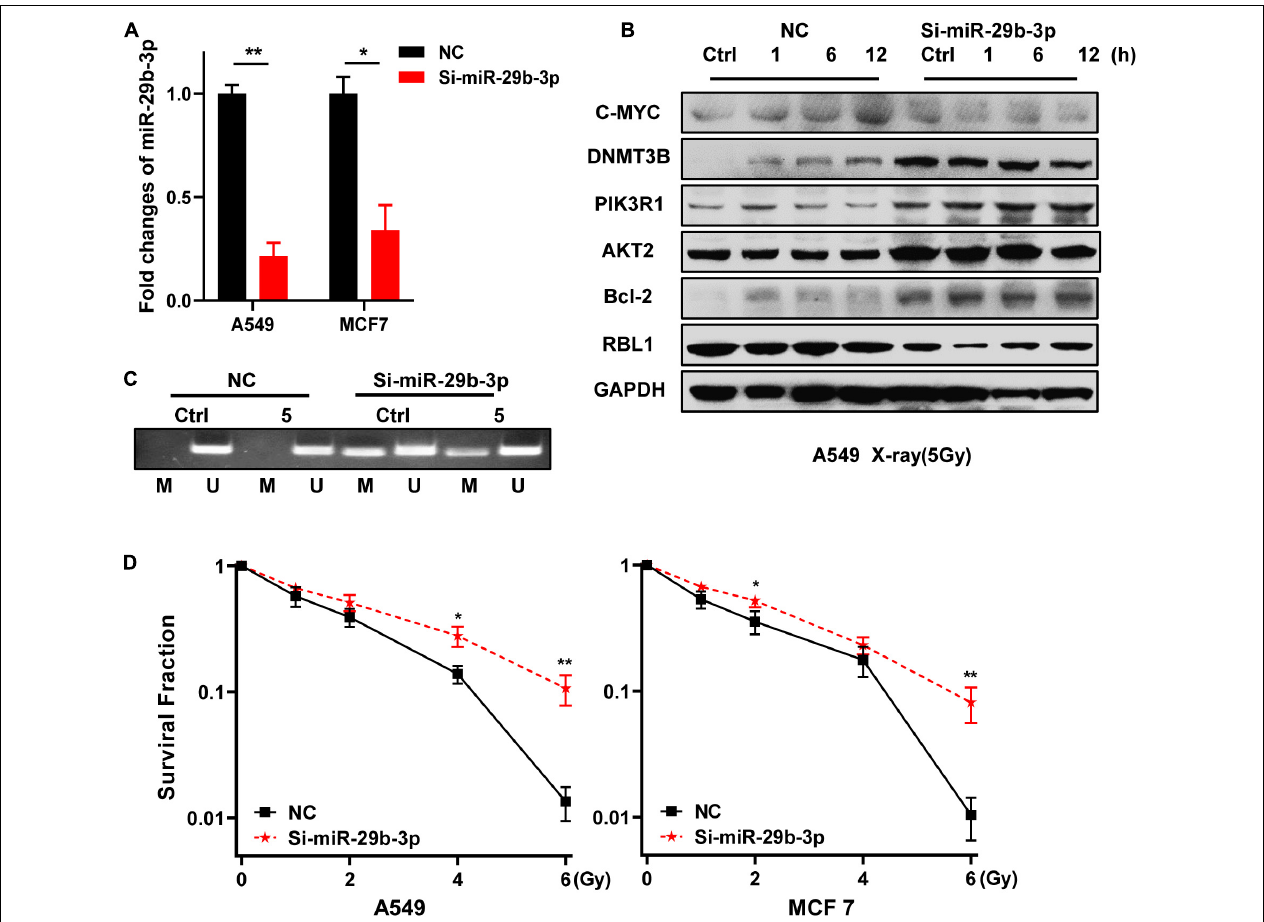
FIGURE 3 | Knockdown of miR-29b-3p enhances the radioresistance of 2D cultured A549 and MCF7 cells by regulating oncogenes. (A) Relative expression levels of miR-29b-3p measured by qRT-PCR in 2D miR-29b-3p knockdown A549 and MCF7 cells. (B) Western blot assay on the expression of c-MYC, DNMT3B, PIK3R1, AKT2, Bcl-2, and RBL1 at indicated time points after 5 Gy X-rays in 2D cultured miR-29b-3p knockdown A549 cells. (C) The changes of the promoter methylation status of RBL1 measured by MSP in 5 Gy X-ray irradiated and unirradiated 2D cultured miR-29b-3p knockdown A549 cells. (D) Colony formation assay on the 2D cultured miR-29b-3p knockdown A549 and MCF7 cells after exposure to 0, 1, 2, 4 and 6 Gy X-rays. Ctrl, unirradiated groups. NC: negative control. Significance was determined by unpaired t -test. * P < 0.05; ** P <